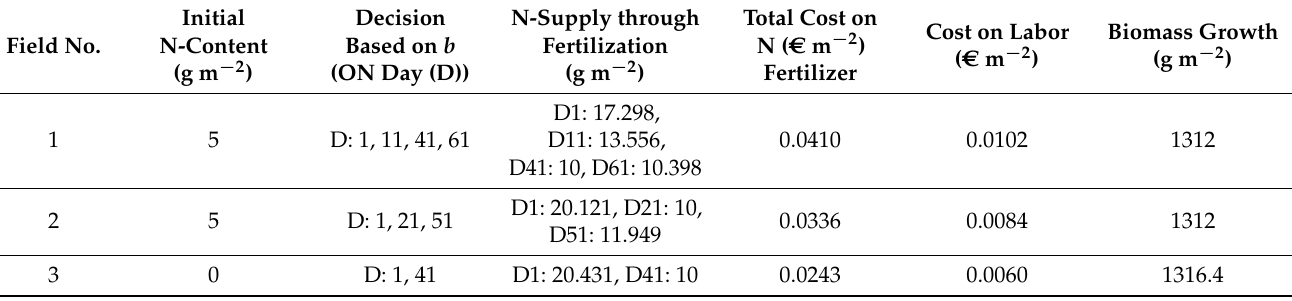
Table 3. Case 2 result: Maximizing the